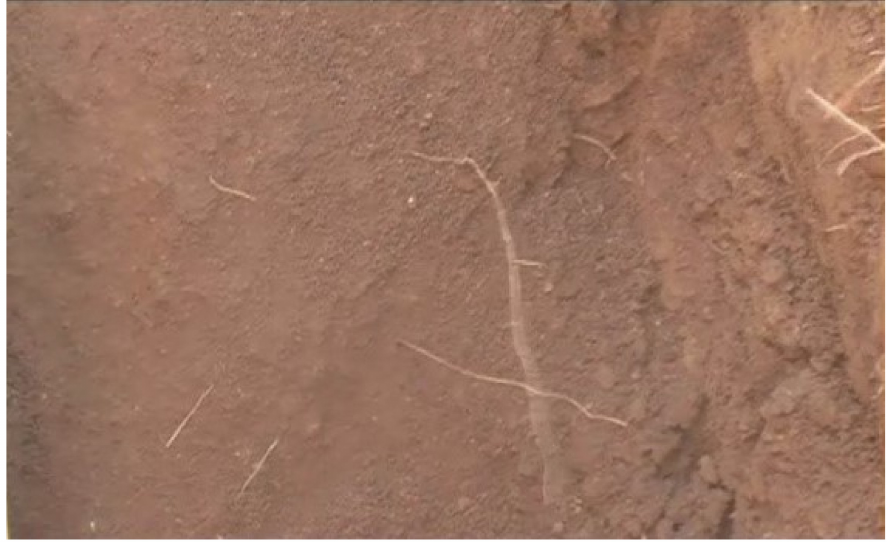
Figure 7. Solonetz soil profile wall at a depth of 25–40 cm (40 years after PMS–70 processing).